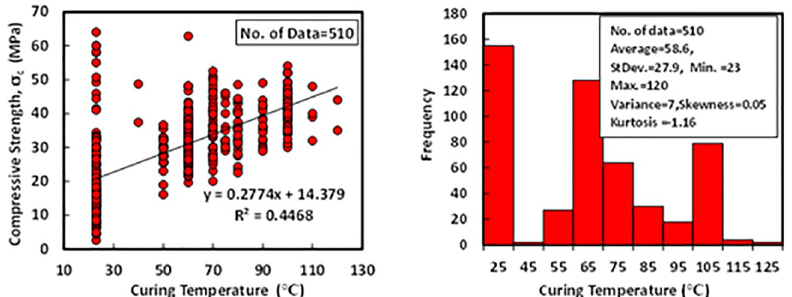
Fig 11. Variation between compressive strength and curing temperature histogram of fly ash-based geopolymer concrete mixtures.